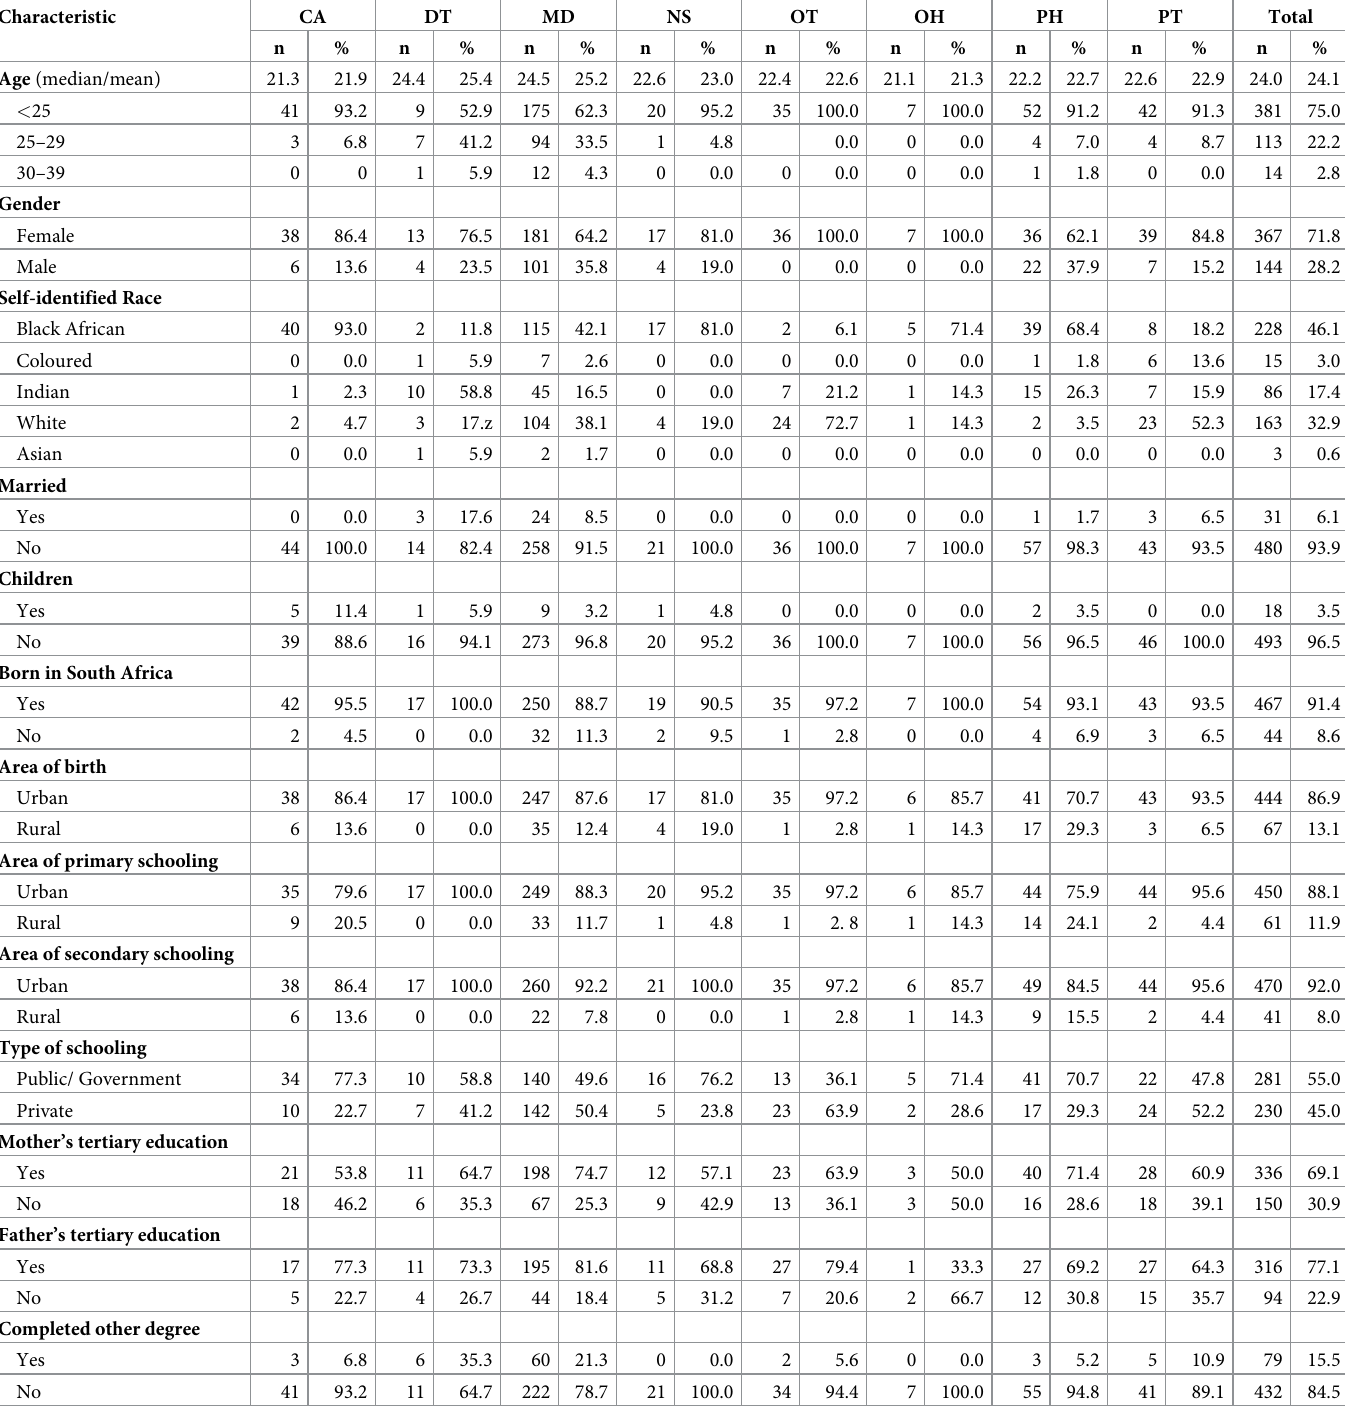
Table 1. Demographic and social characteristics of WISDOM cohort